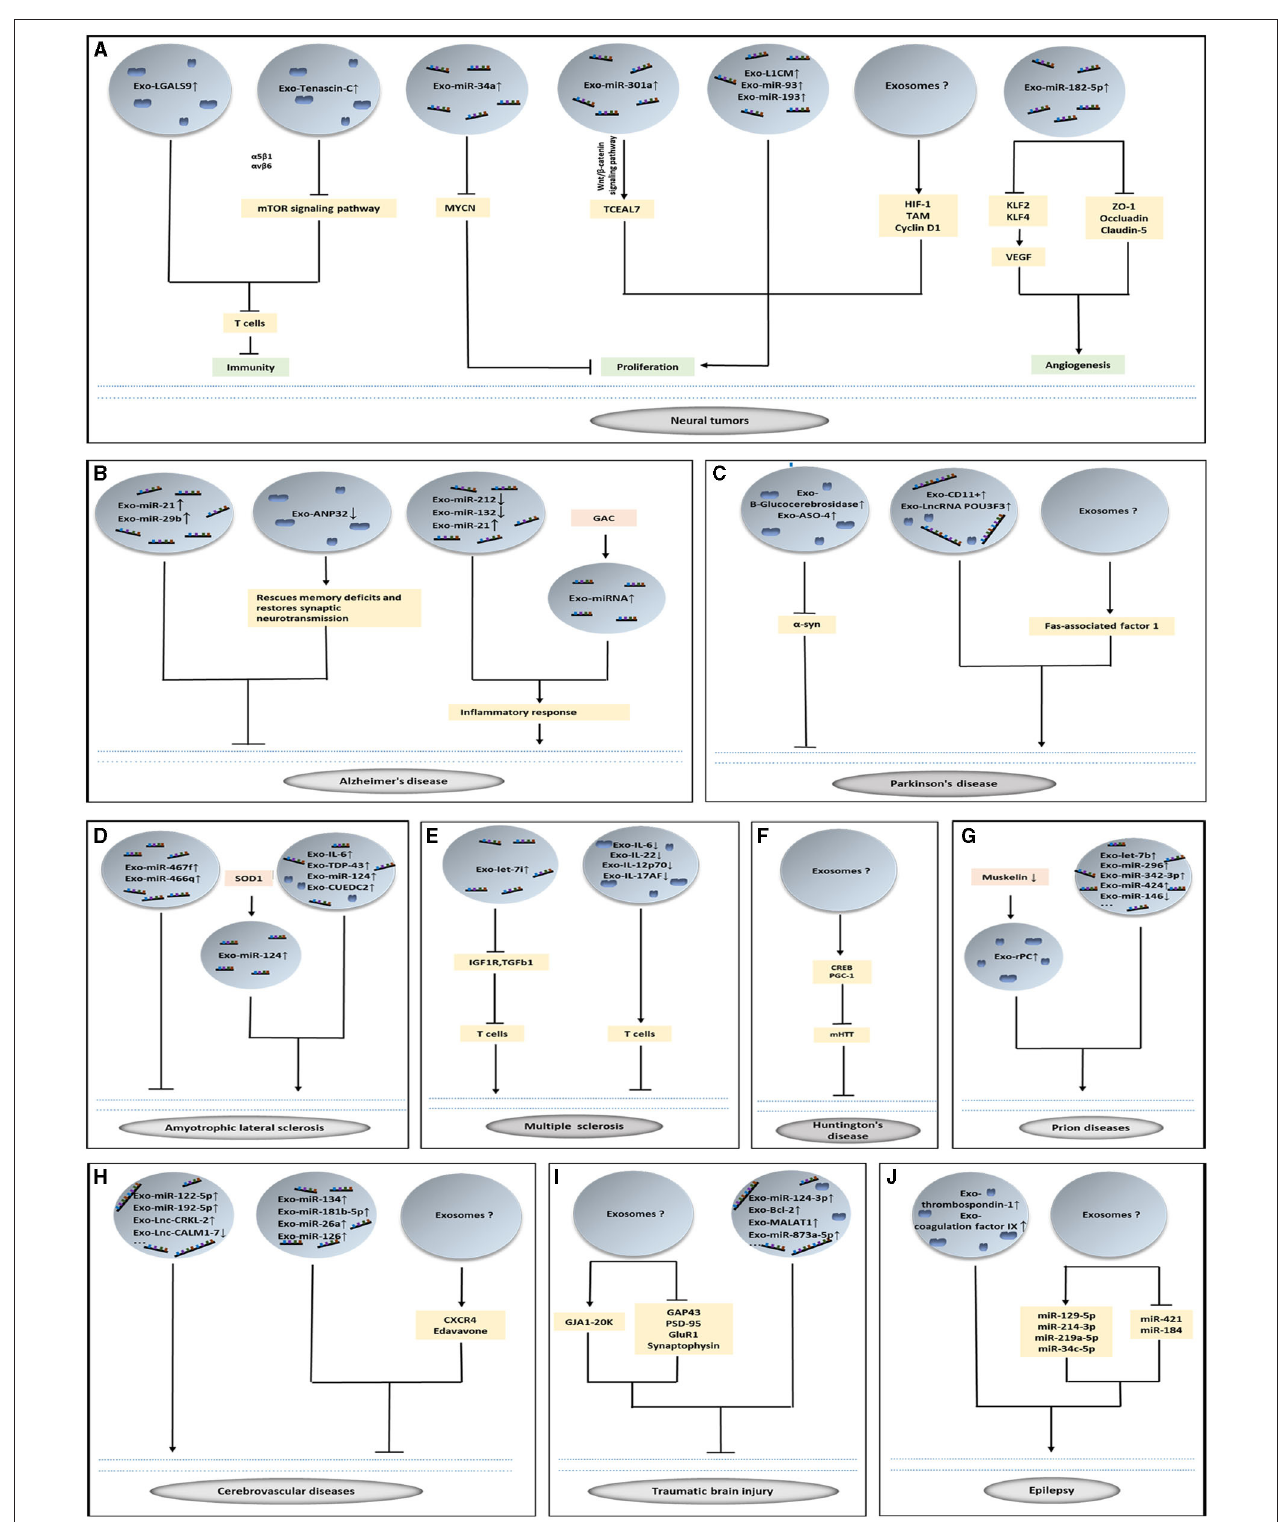
FIGURE 1 | The role of exosomes in brain diseases. (A–J) Exosomes loading with vital cargoes promote or inhibit the occurrence of disease and play a therapeutic role in nervous system diseases.